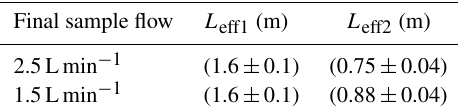
Table 3. Results of the transmission calibration of the DMA-train. The two free fit parameters for the threefold Gormley and Kennedy Eq. (5) are reported for the two sample flow